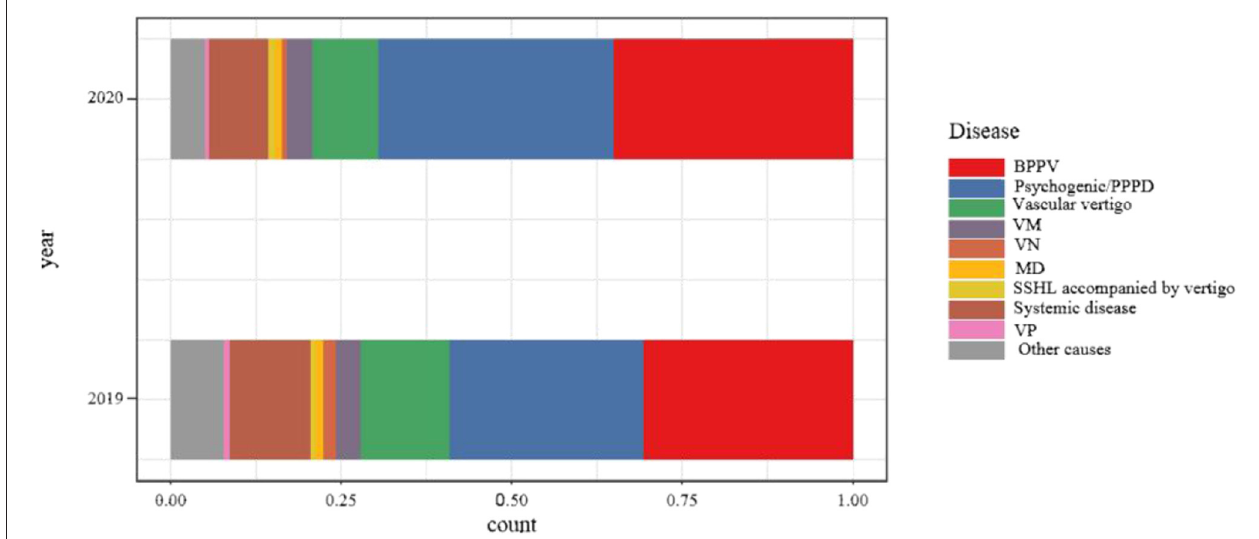
FIGURE 1 | Comparison of etiologic distribution of patients with dizziness/vertigo of the study period in 2019 and 2020.